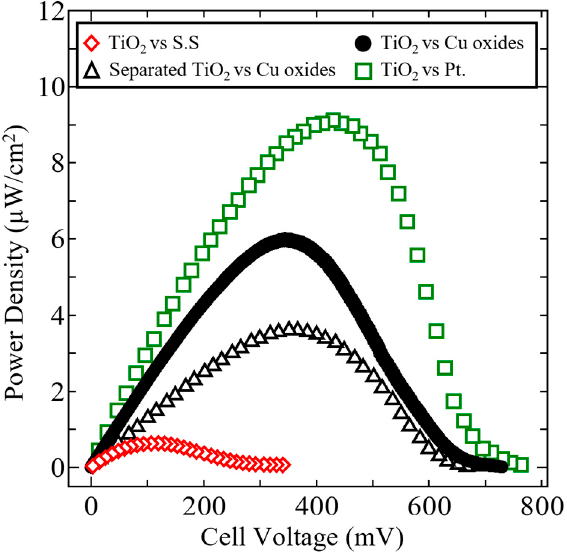
Figure 4. Power vs. cell voltage (P–V) of four types of cells. Table 1. P, I, and V values of the cells under irradiation.